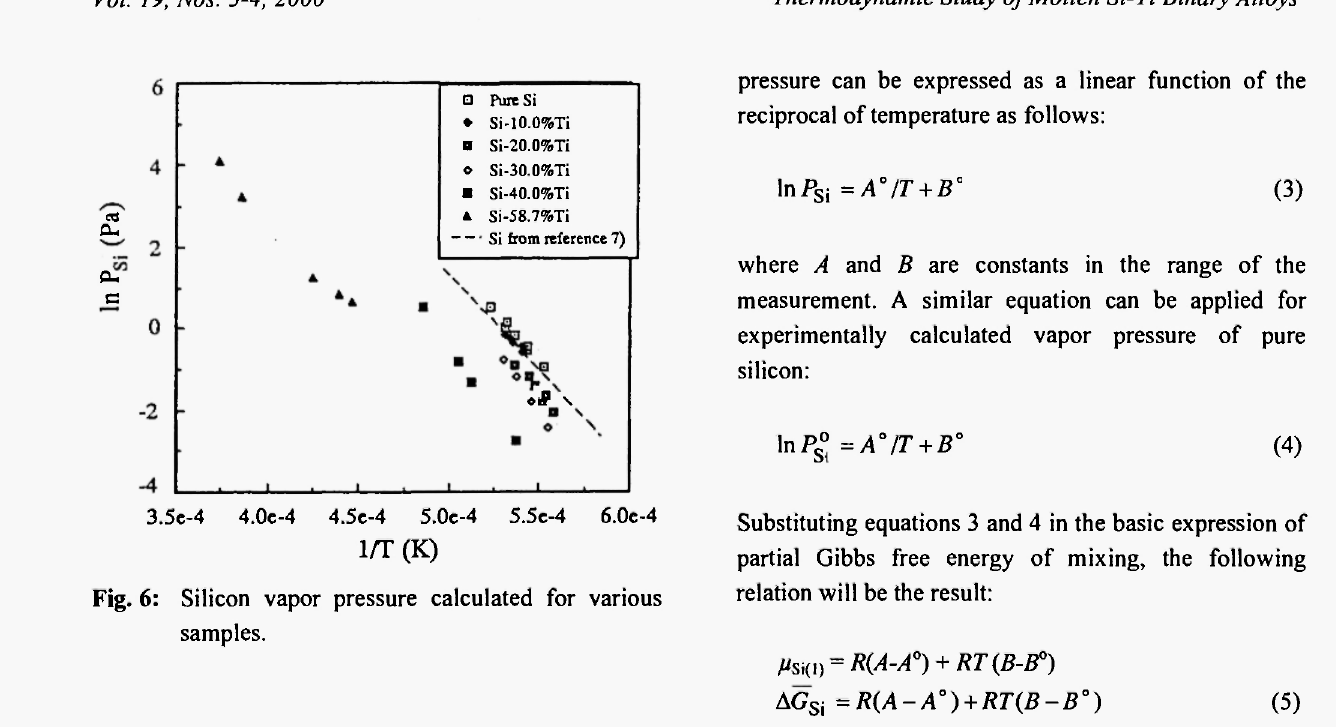
Fig. 6: Silicon vapor pressure calculated for various samples.